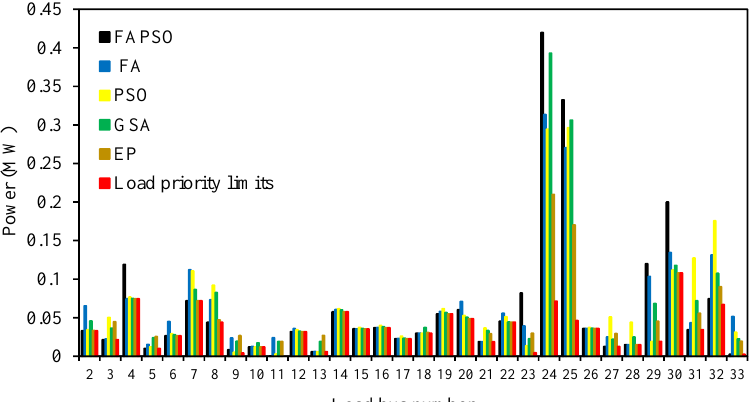
Figure 12. Load buses demand after implementing the load shedding process based on FAPSO, FA, PSO, EP and GSA optimizations at time 15:00 for island case 1.